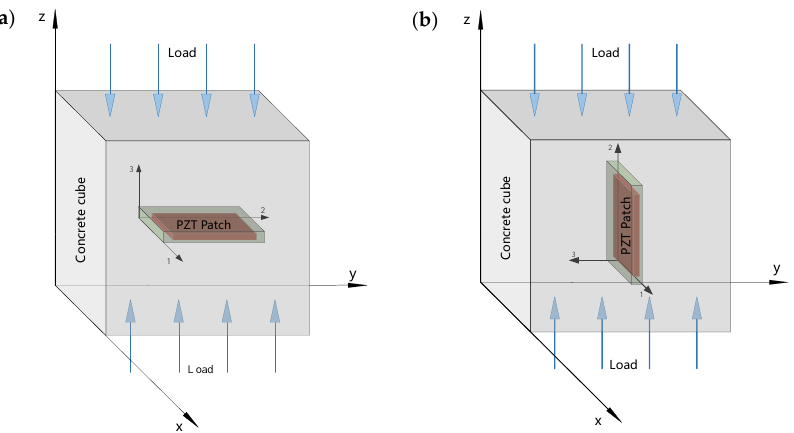
Figure 7. Typical embedding positions of PZT sensors with relative angles between the loading direction and normal vibration plane: ( a ) 0 ° and ( b ) 90 ° .